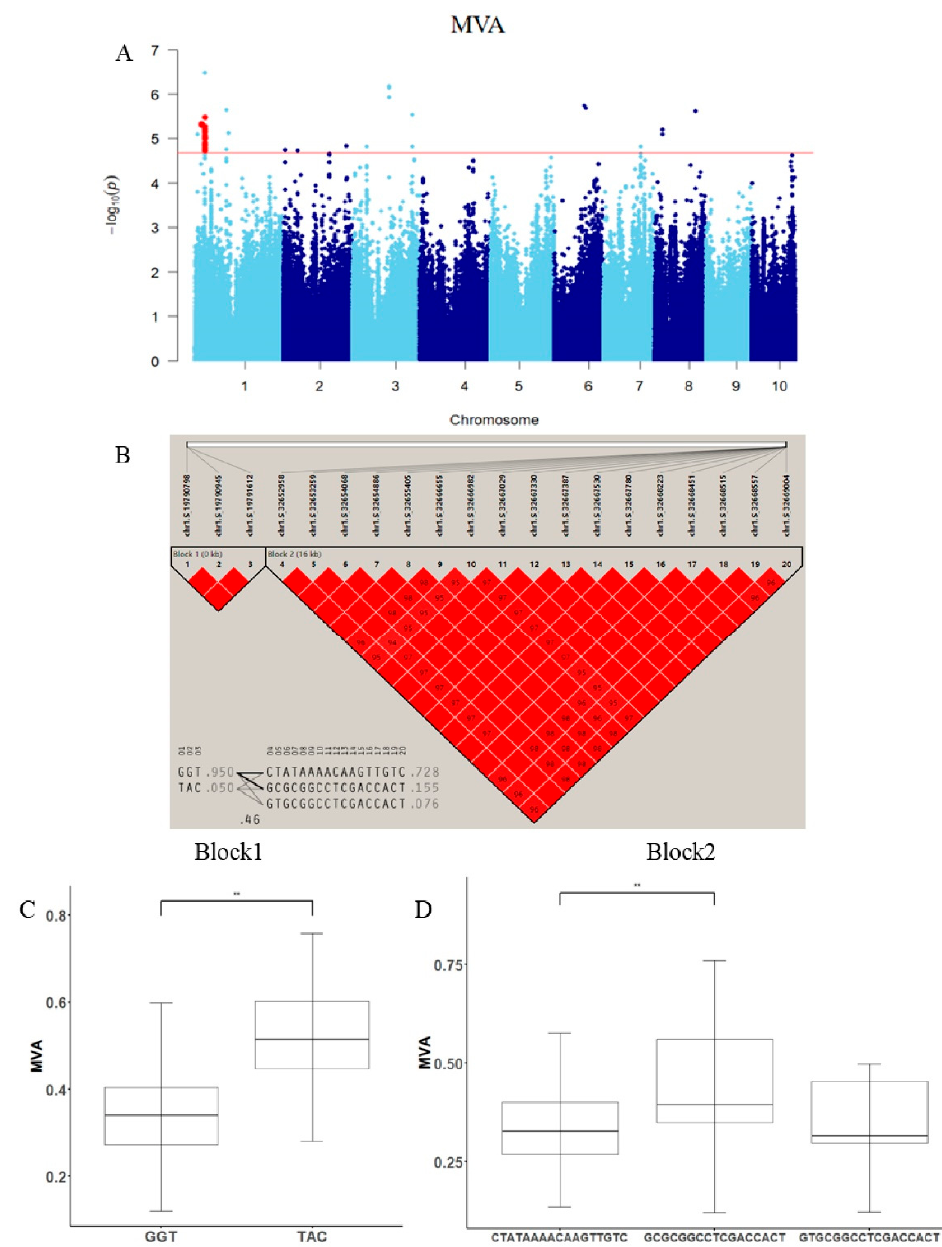
Figure 7. Analysis of haplotype ( A , B ) and phenotypic difference ( C , D ) of SNPs related to the midvein area of maize ear leaf. ** p ≤